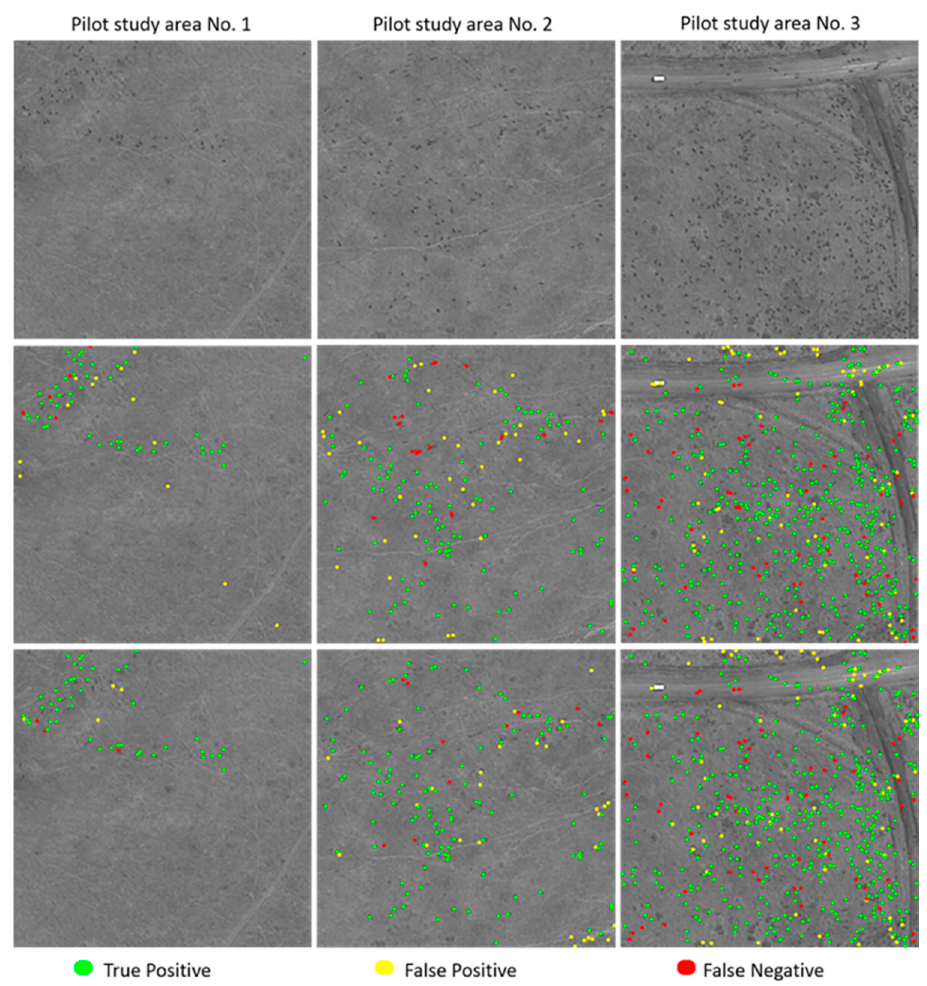
Figure 6. Results regarding large mammal detection in the three different pilot study areas. The columns show images of the three pilot areas: No. 1 is of low complexity, No. 2 of moderate complexity and No. 3 of high complexity. The first row contains the original panchromatic satellite images; the second row illustrates results based on the thresholding method; and the third row illustrates the results obtained using the method proposed in this study (i.e., ANFIS-wavelet). The green, red and yellow dots indicate true positive, false negative and false positive results, respectively.